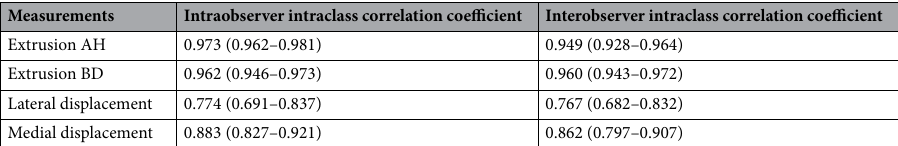
Table 3. Intraobserver and Interobserver reliability for meniscal deformation measurements. Data are presented as intraclass correlation coefficients, with 95% confidence interval in parentheses.